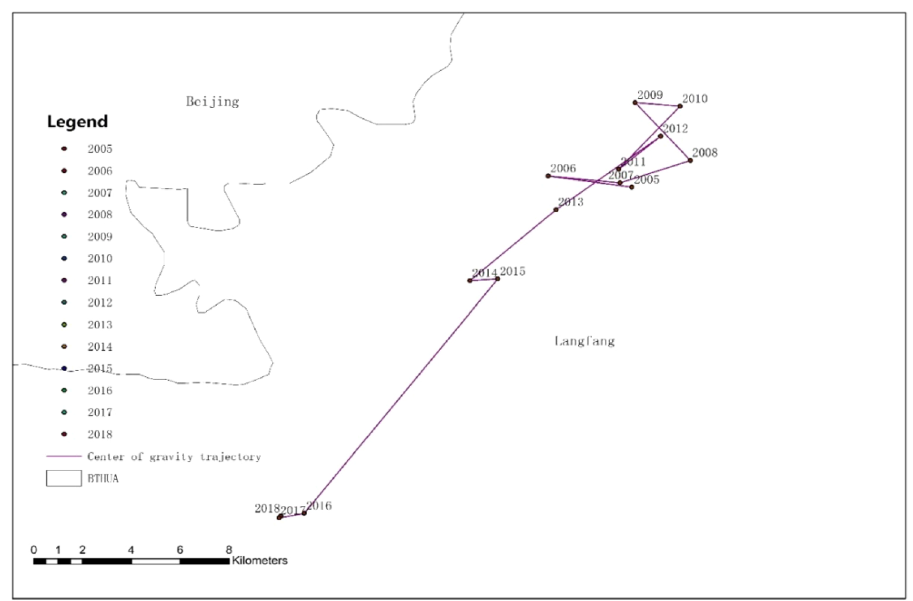
Figure 5. The change tracking of the population gravity center in BTHUA. It mainly shows the migration of the BTHUA population gravity center in the past 14 years (more details in the supplementary